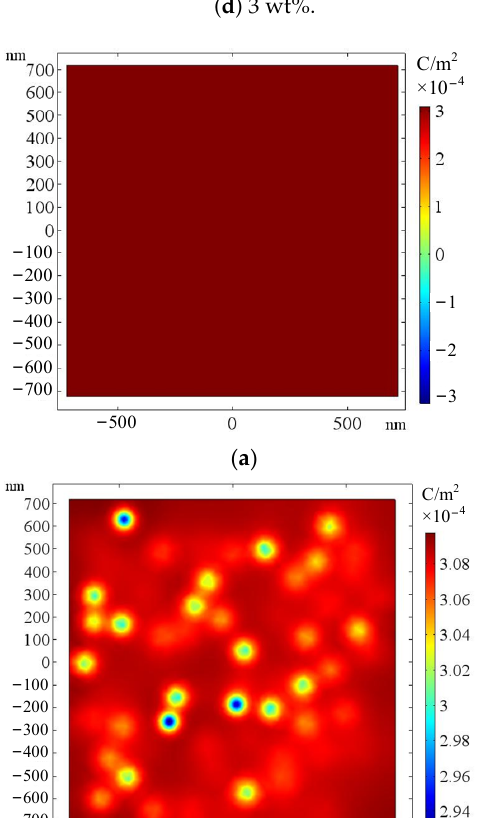
Figure 9. Electron motion state with nano doping concentration of ( a ) 0 wt%, ( b ) 1 wt%, ( c ) 2 wt%, ( d ) 3 wt%.